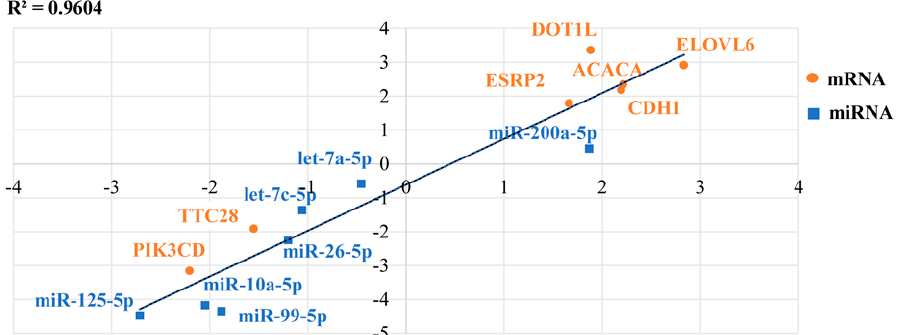
Figure 8. An illustration of the qRT-PCR confirmation for the RNA-seq. The correlations of the gene expression level of the 14 differentially expressed genes between lactating and non-lactating crops using RNA-Seq and a qRT-PCR. The X-axis and Y-axis show the log 2 Fold change (T/C) measured by the RNA-seq and qRT-PCR, respectively. T represents lactating group and C repre- sents non-lactating group. The hypoxanthine phosphoribosyltransferase 1 ( HPRT1 ) gene was used as a housekeeping internal control.